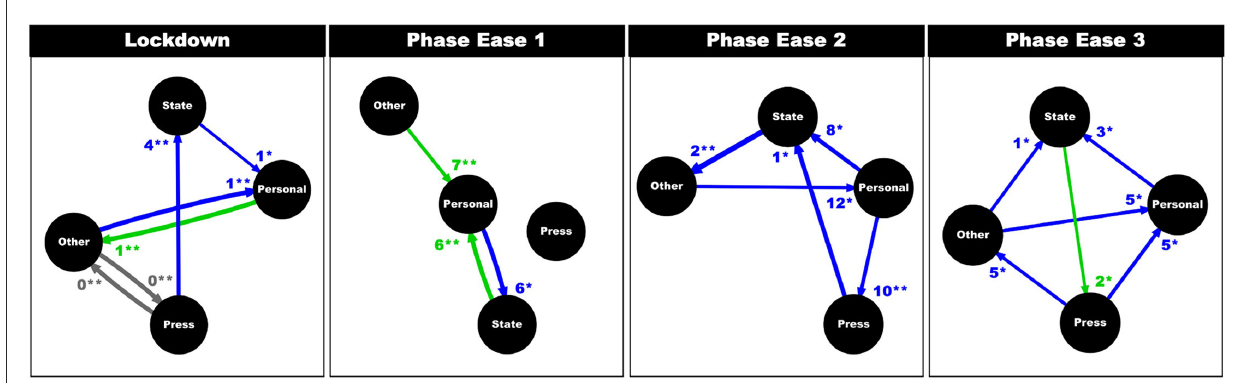
FIGURE6 Results from cross correlation functions and lagged regressions, per phase. Each flowchart exhibits relationships between the four sectors, with regards to positive (green; above average sentiment in X is likely to lead to above average sentiment in Y), negative (blue; above average sentiment in X is likely to lead to below average sentiment in Y), or no (gray) correlation in mean sentiment. Arrows represent flow of influence and thickness of arrow represents strength of correlation. Lag (days) at which cross correlation is maximum is noted at arrowhead, along with statistical significance ( p < 0.5* , p < 0.01**). Note that at the start of the pandemic (LD and PEl) Personal accounts were initially influenced by State and Other accounts (in both positive and negative directions). However, by PE3, Personal accounts were no longer correlated with State and Other accounts but Press and Other